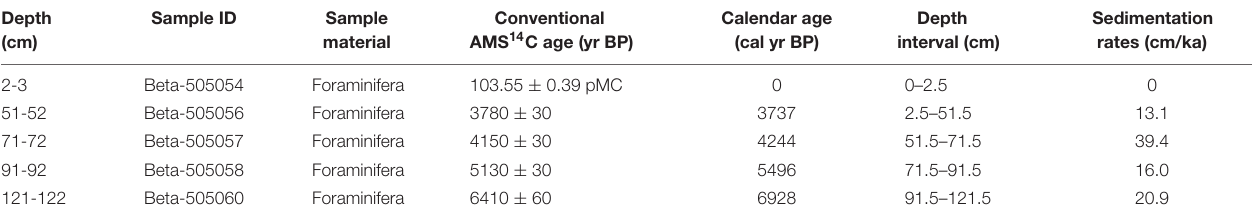
TABLE 2 | AMS 14 C dating age model of Core